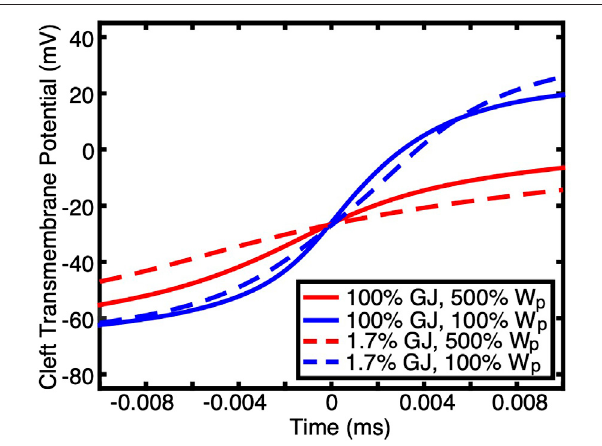
FIGURE 3 | Transmembrane potentials during the depolarization phase of APs at one end of a cell (the membrane at the intercalated disc) are shown for simulations having non-uniform ion channel distribution with different GJ coupling and W p . Time was shifted such that the midpoint of the upstroke occurred at 0 ms. W p had a greater effect on the rate of depolarization than GJ